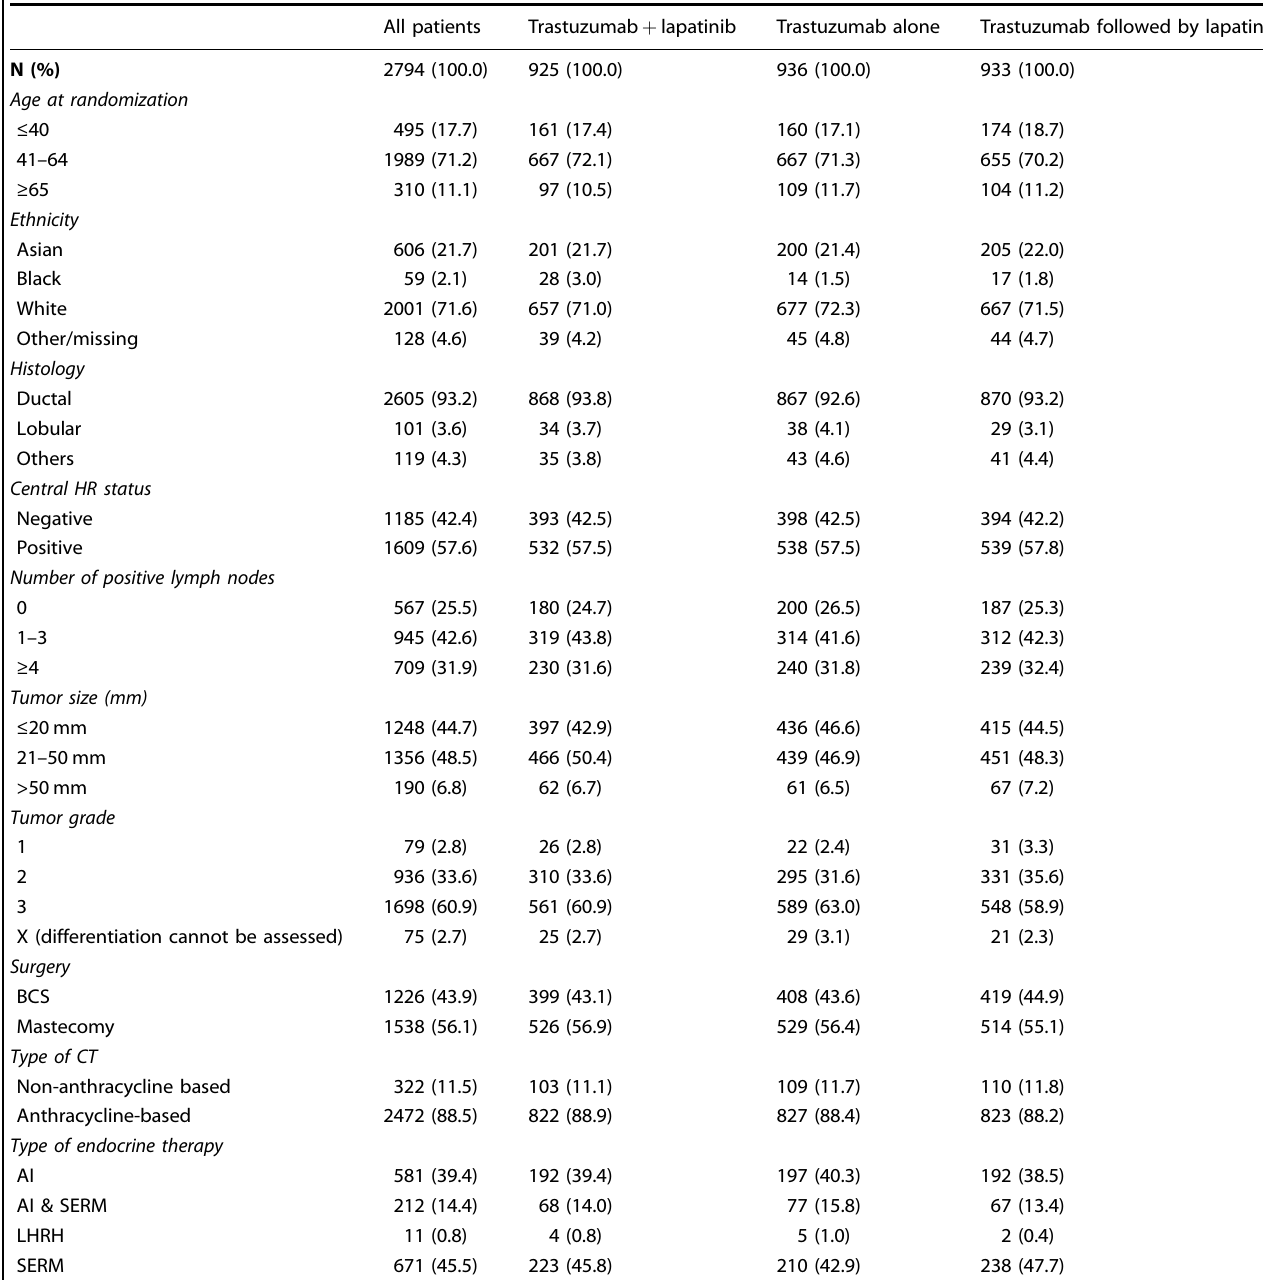
Table 1. Characteristics of the patients (overall and per randomization